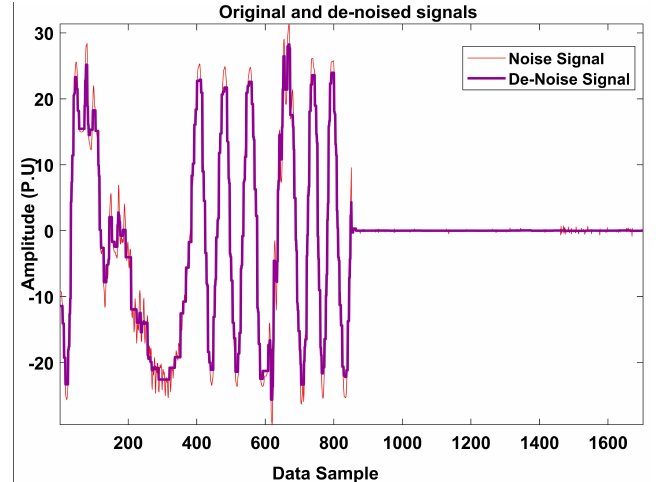
Figure 10. Fault Current With De-Noise